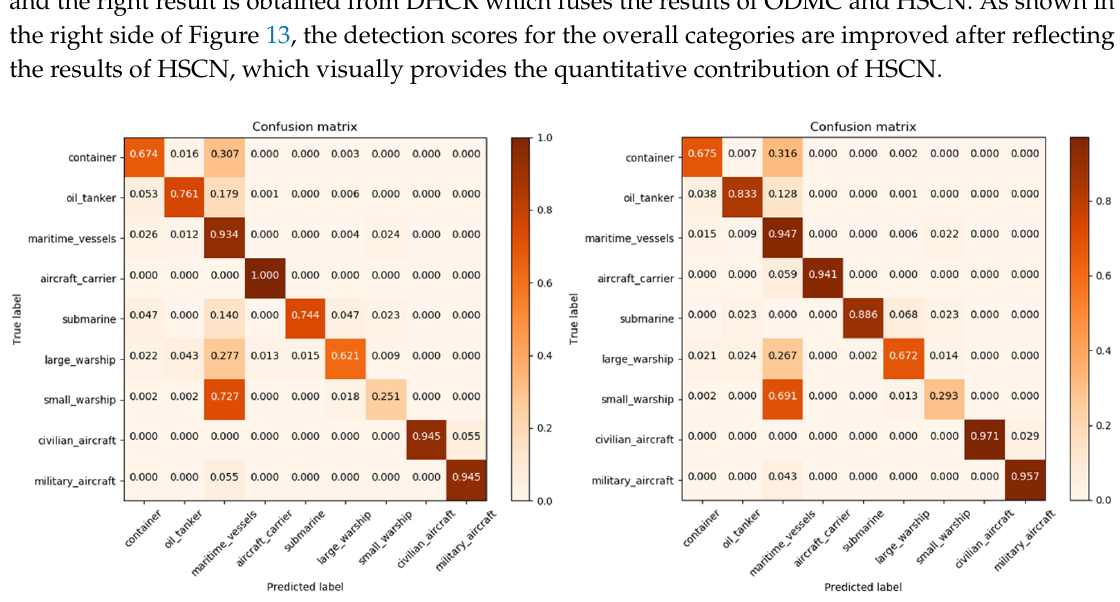
Figure 13. Comparison of confusion matrices before ( left ) and after ( right ) the hierarchical classification refinement. In other words, the left result is achieved after the inference of only ODMC and the right result is obtained from DHCR which fuses the results of ODMC and HSCN. For the overall categories, the detection score is improved after reflecting the results of